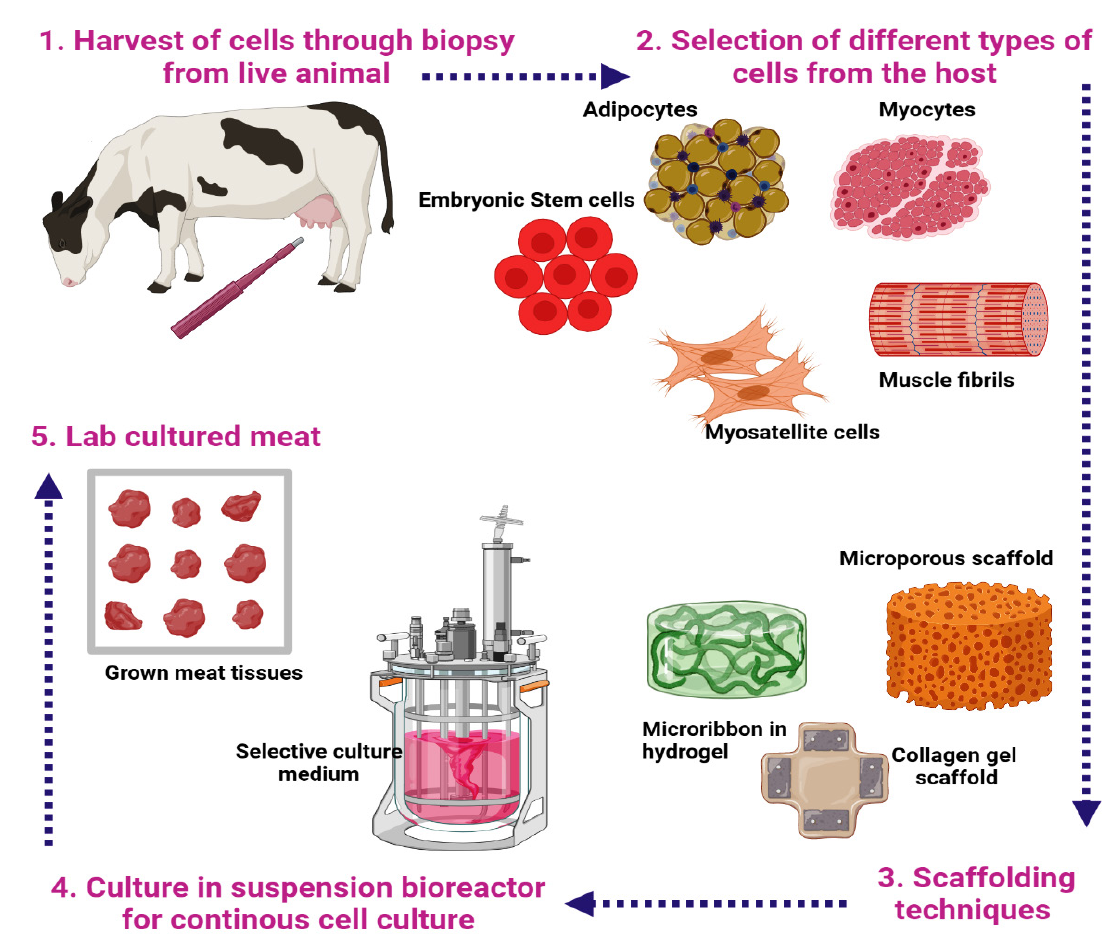
Figure 1. A pipeline for the production of illustrating the common stages involved in the production of a cultured meat product.